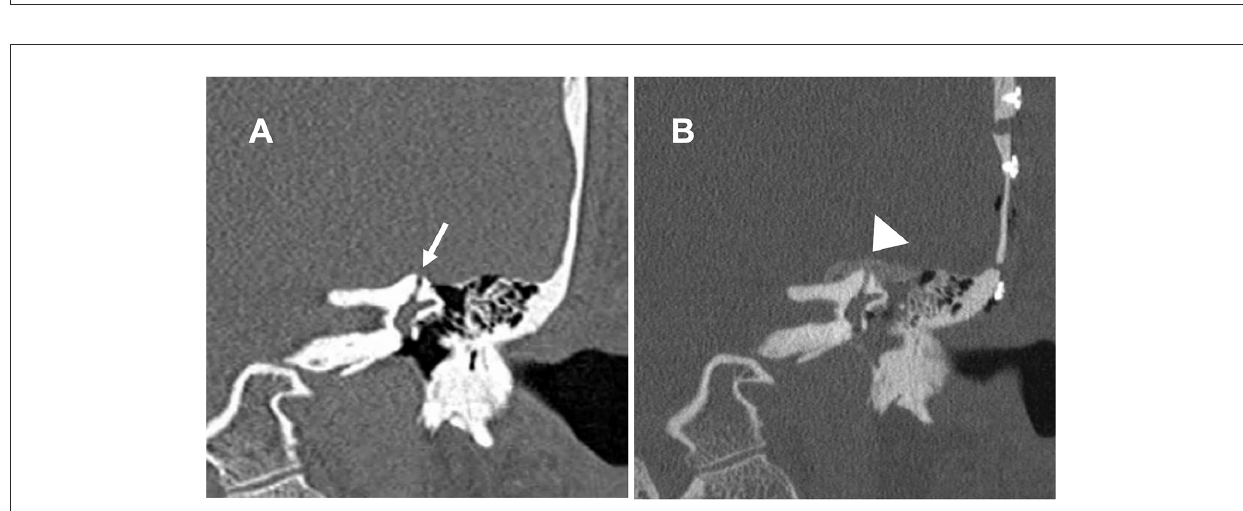
FIGURE5 Coronal cut of a high-resolution CT scan of the left temporal bone. (A) The dehiscence of the left superior canal (arrow). (B) The bone dust plugging the dehiscence and covering the superior canal (arrowhead).